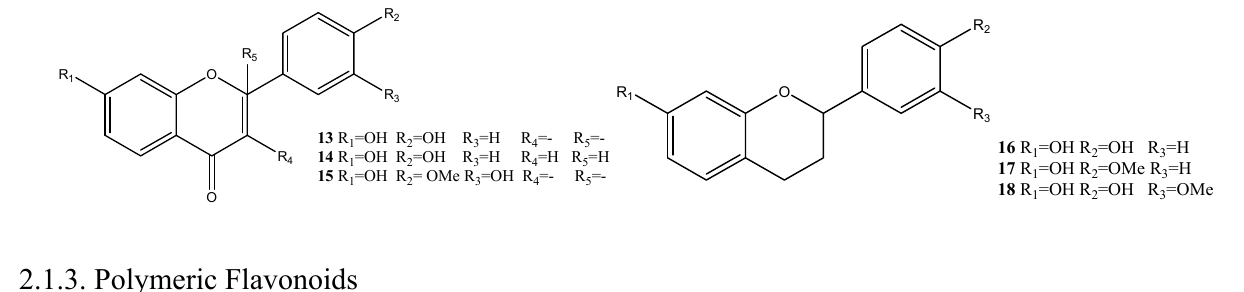
Figure 3. Structures of flavanones and